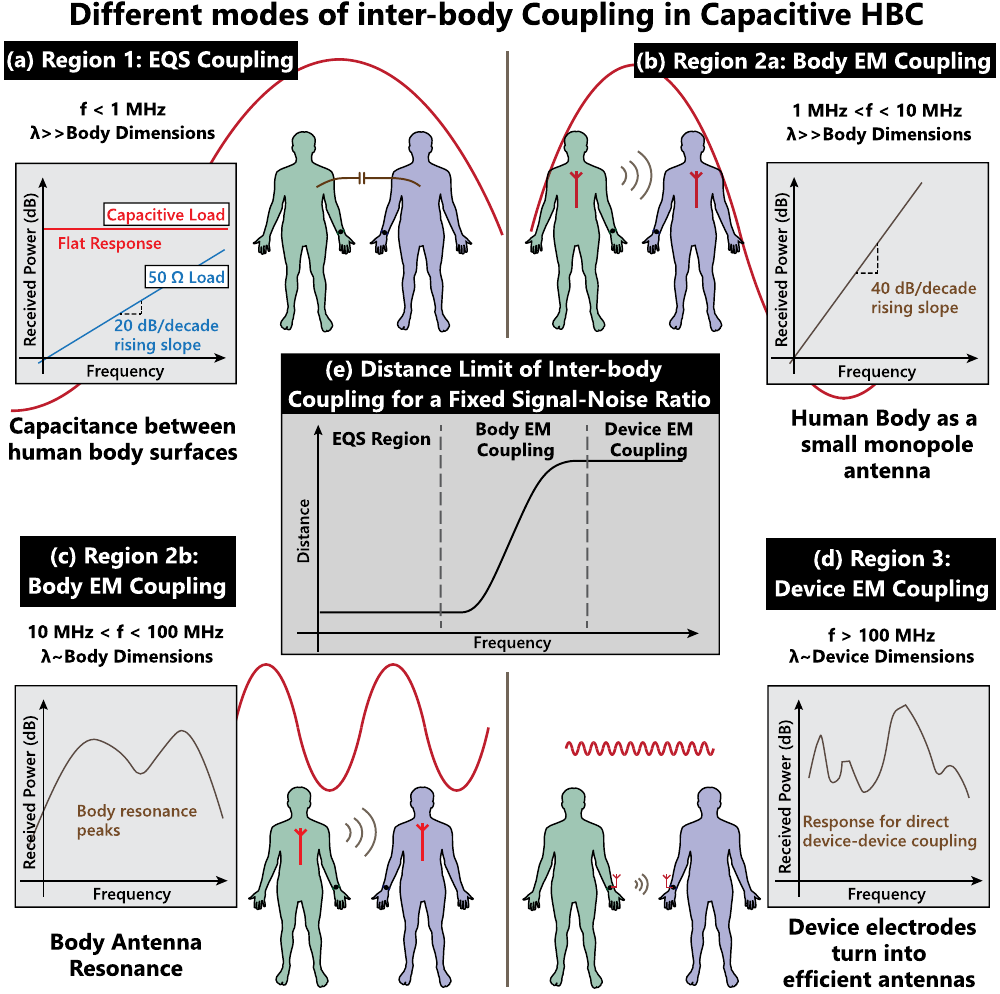
Figure 4. Inter-body coupling modes for Capacitive HBC users: ( a ) EQS Region, f < 1 MHz , capacitive coupling dominates. ( b ) 1 MHz < f < 10MHz , body starts to act as a small monopole antenna, giving a 40dB/ decade rising response in coupling. ( c ) 10MHz < f < 100 MHz , wavelength comparable to body dimensions; Body-antenna resonance peaks occur. ( d ) f > 100 MHz , wavelength comparable to device dimensions; the devices start coupling through EM leakage. ( e ) The trend of maximum distance, over which signals from inter-body coupling can be detected (for a fixed SNR at the transmitter), over frequency. The distance limit is low independent of frequency for EQS coupling, increases rapidly once the two bodies start becoming efficient antennas, and becomes saturates once the devices become efficient antennas